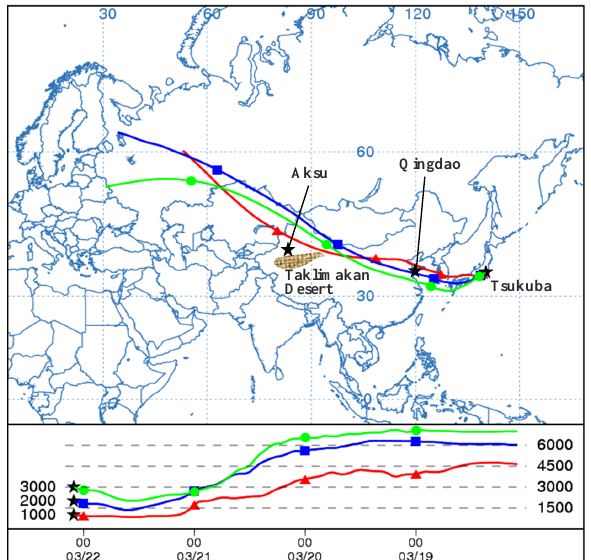
Fig. 3. Three-dimensional air mass backward trajectories during sampling periods of March 2002. The NOAA/ARL HYSPLIT model (Draxler and Rolph, 2003) was used for the calculation. The trajectories started at the altitude of 1000m, 1500m, and 3000m above the sampling site in